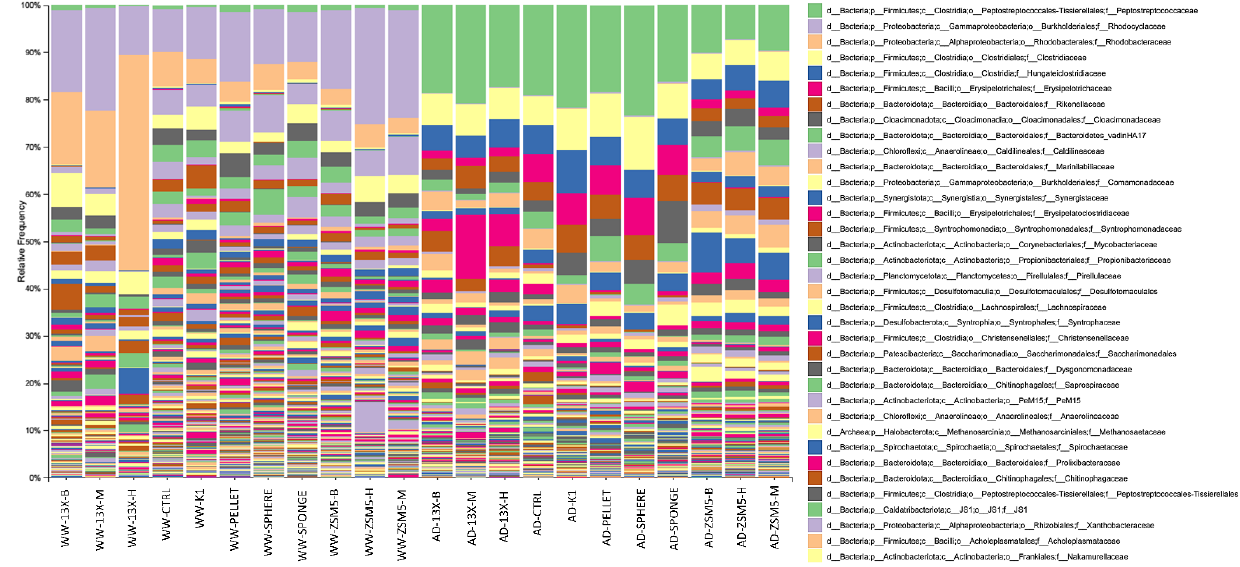
Figure 10. Bar plot of relative frequencies of identified families.